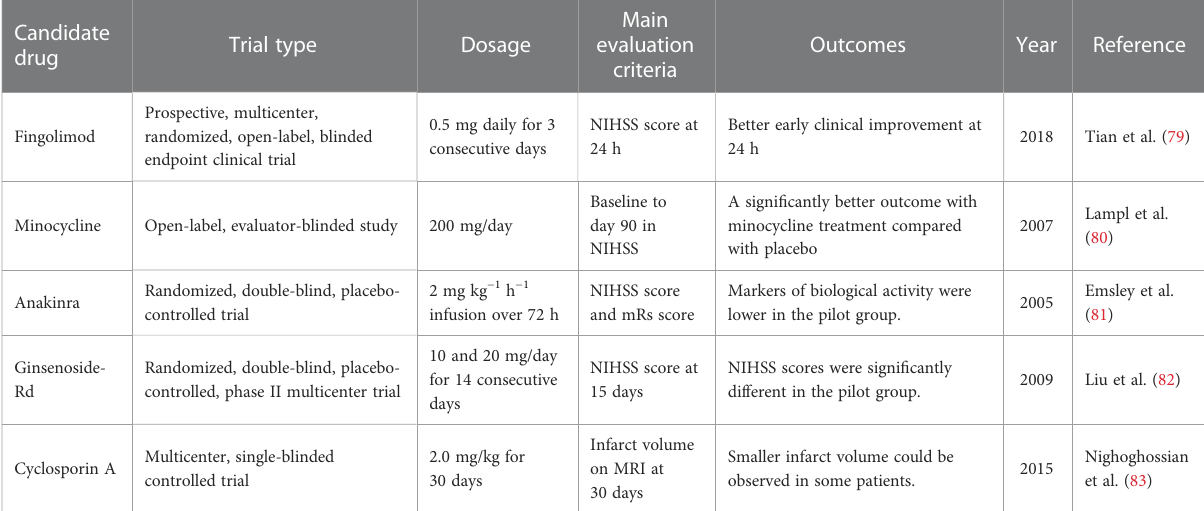
TABLE 1 Potential clinical immunotherapeutic strategies NIHSS , National Institutes of Health Stroke Scale; mRs , modi fi ed Rankin scale.